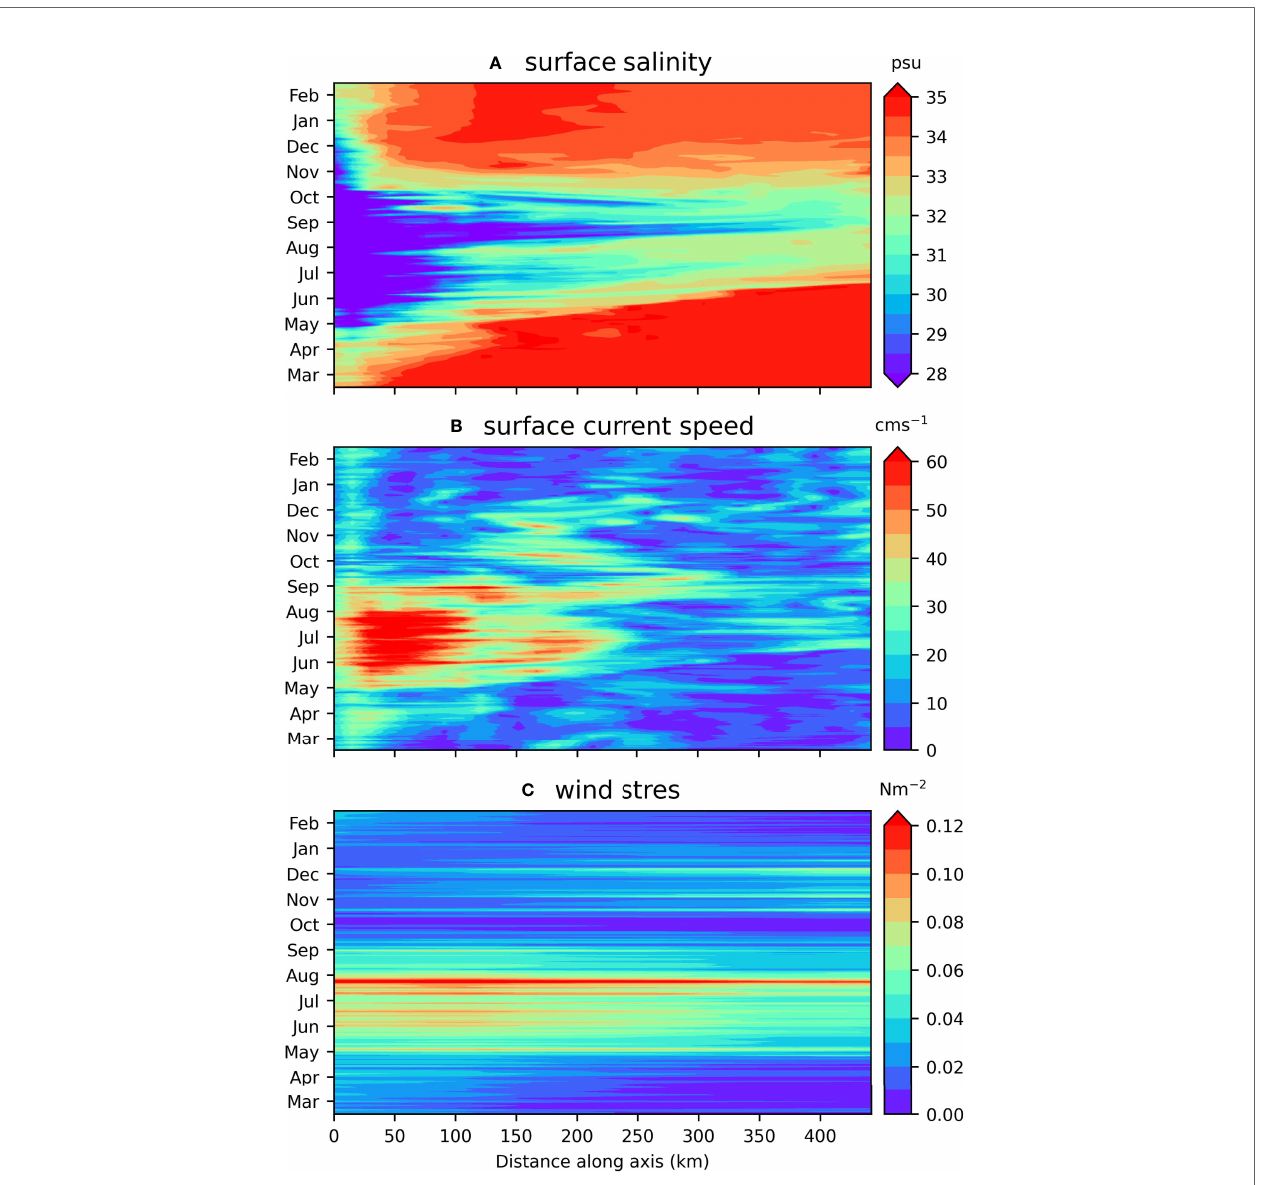
FIGURE 7 | Time evolution of surface salinity (top panel), surface current speed (middle panel) and wind stress magnitude (bottom panel) along an axis of IR plume shown in Figure 4D . Salinity and current data is taken from the fi rst year of experiment